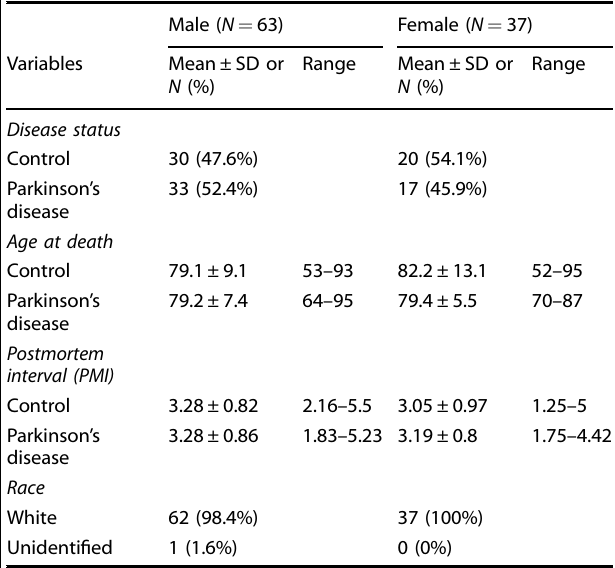
Table 1. Cohort characteristics including disease status, age at death in years, postmortem interval (PMI) in hours, and